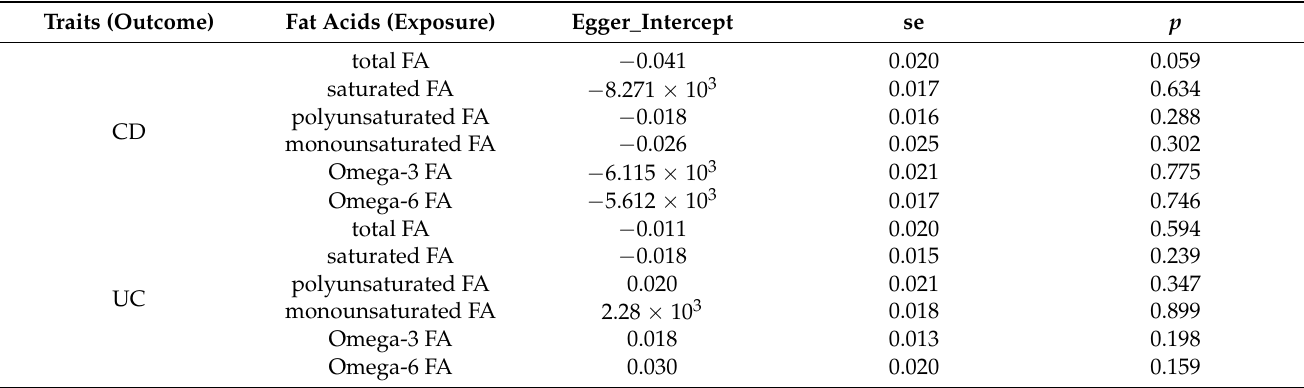
Table 5. The pleiotropic test of FAs genetic variants in inflammatory bowel disease (IBD) Genome- wide summary association study (GWAS)